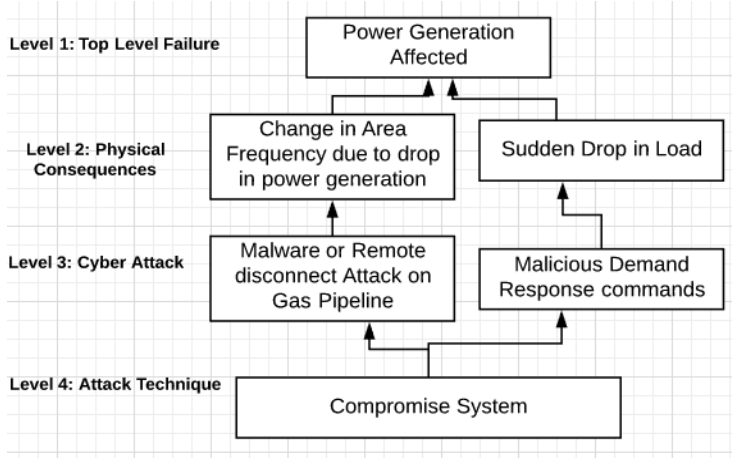
Figure 2. Attack tree.